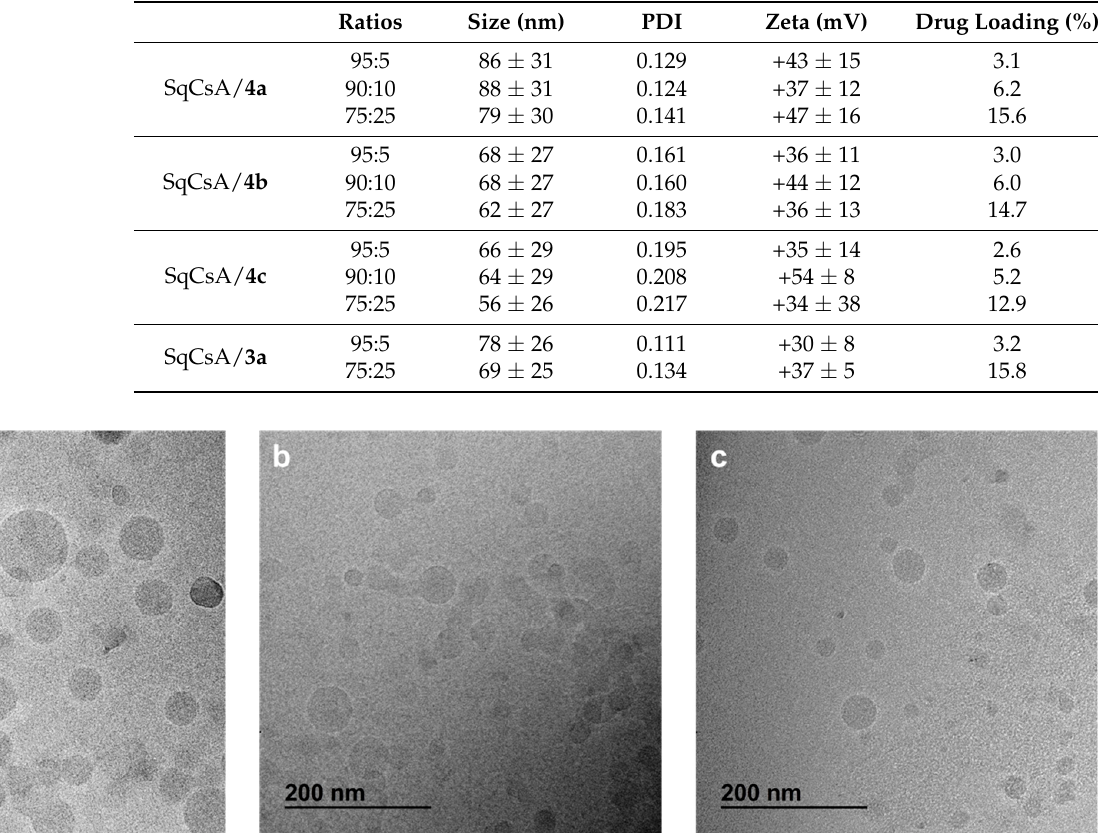
Table 1. Size, Polydispersity index (PDI), Zeta potential and Drug loading of 2a or 2b for SqCsA/ 4a , 4b , 4c or 3a NPs at different ratios.